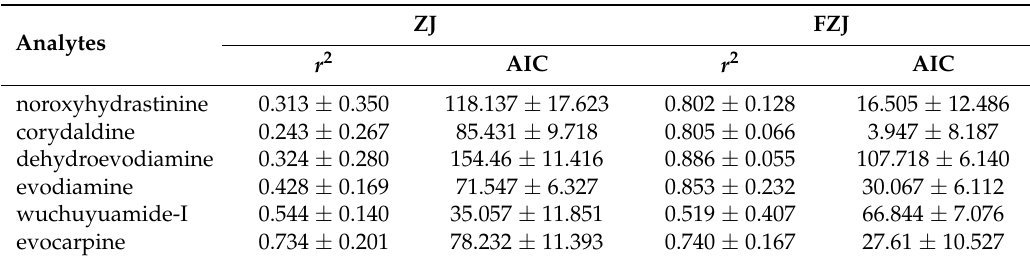
Table 2. Two-compartment model fitting result of the alkaloids in rat plasma after oral administration of ZJ and FZJ